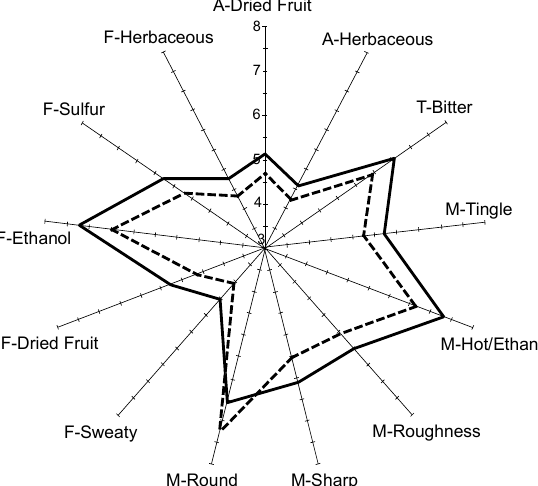
Figure 4. Spider chart of mean values of sensory attributes found to be significantly different ( p < 0.05) by trained panel ( n = 10) between wines produced with S. cerevisiae alone under fermentation temperature regime I (solid line) or with sequential inoculation of Mt. pulcherrima / S. cerevisiae under fermentation temperature regime III (dashed line). ‘A’ denotes aroma attribute, ‘T’ denotes taste attribute, ‘M’ denotes mouthfeel attribute, and ‘F’ denotes flavor attribute.